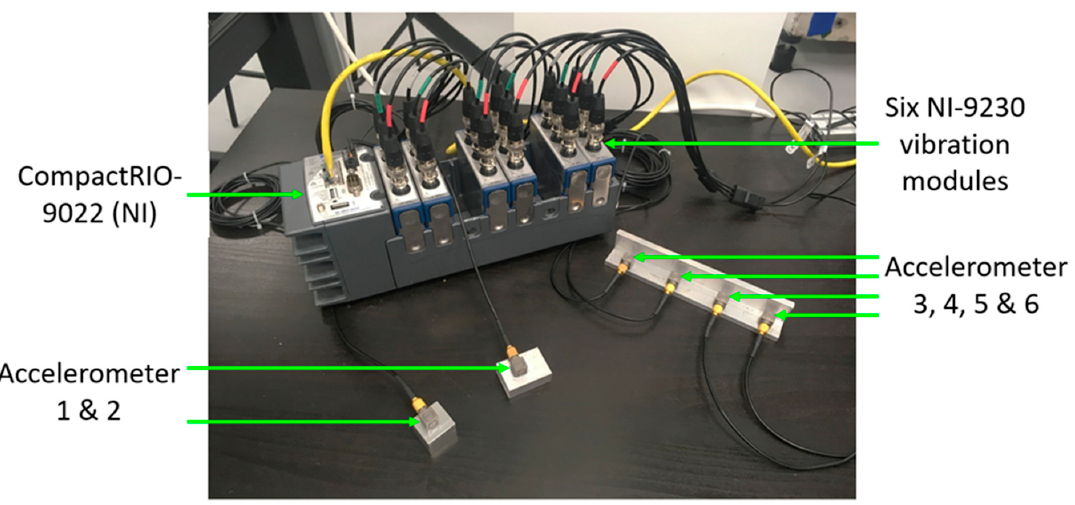
Figure 1. The developed multi-accelerometer live monitoring system, which includes six triaxial IEPE accelerometers, a CompactRIO-9022 controller, with an eight-module slot chassis attached and six NI-9230 vibration and sound modules integrated.